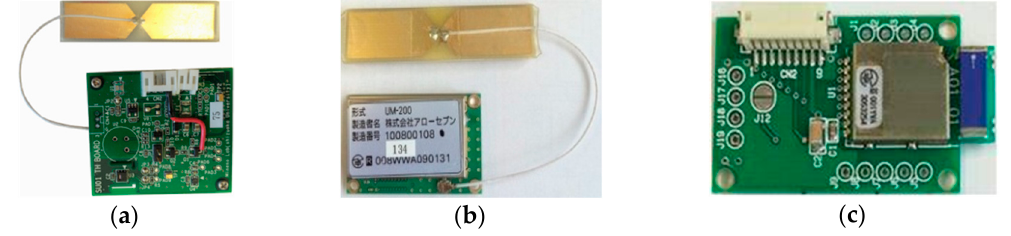
Figure 4. ( a ) Temperature and humidity sensor node, ( b ) 2.4 GHz band wireless module, and ( c ) 400 MHz band wireless module.